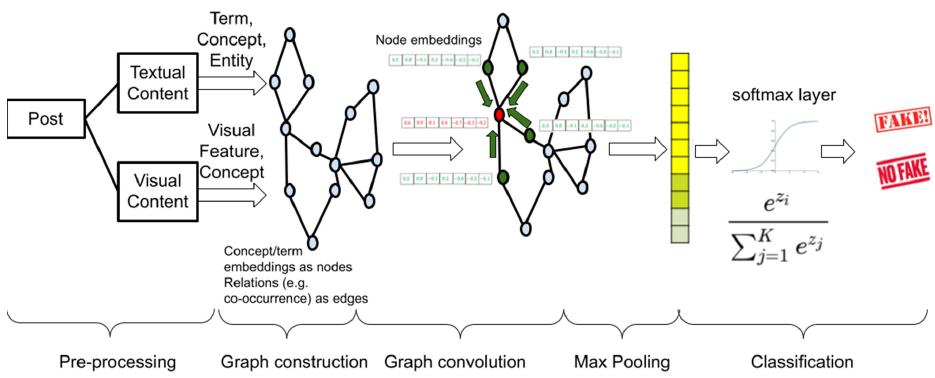
Figure 3. An overview of the fake news detection process using